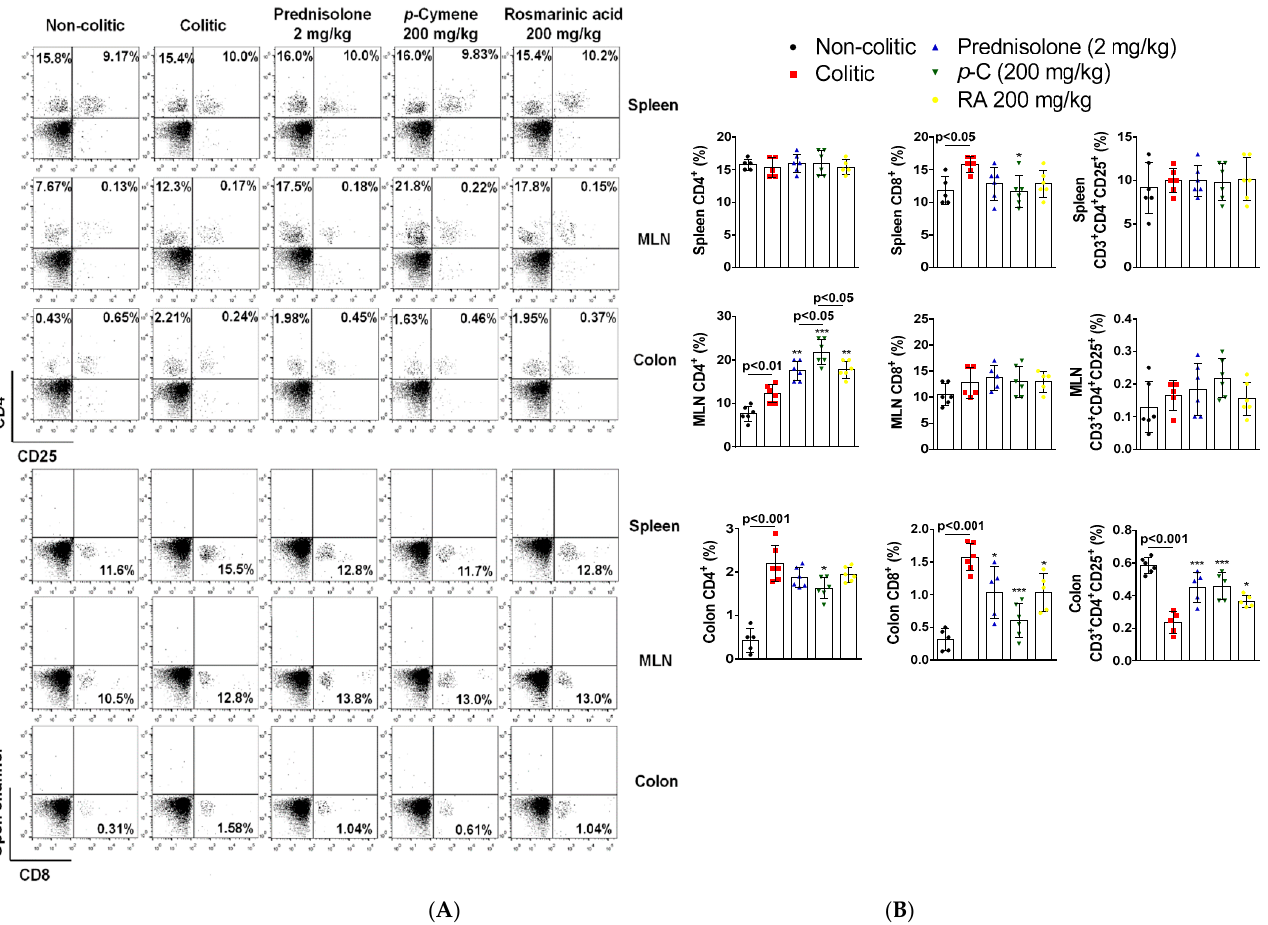
Figure 7. Effect of oral administration of p -C and RA in the modulation of T cell populations in a TNBS-induced ulcerative colitis rat model. ( A ) Representative dot plots from flow cytometry analysis (FACS) analysis of T lymphocytes gated for cluster of differentiation (CD)4 + , CD8 + , and CD3 + CD4 + CD25 + cells; ( B ) T cell percentages (%) in the assessed samples (colon, spleen, and mesenteric lymph nodes (MLN)). Data are expressed as mean ± standard error percentage of the total number of cells, having been analyzed by one-way ANOVA followed by Dunnett’s or Tukey’s test. *** p < 0.001, ** p < 0.01, * p < 0.05 compared to colitic control groups ( n =